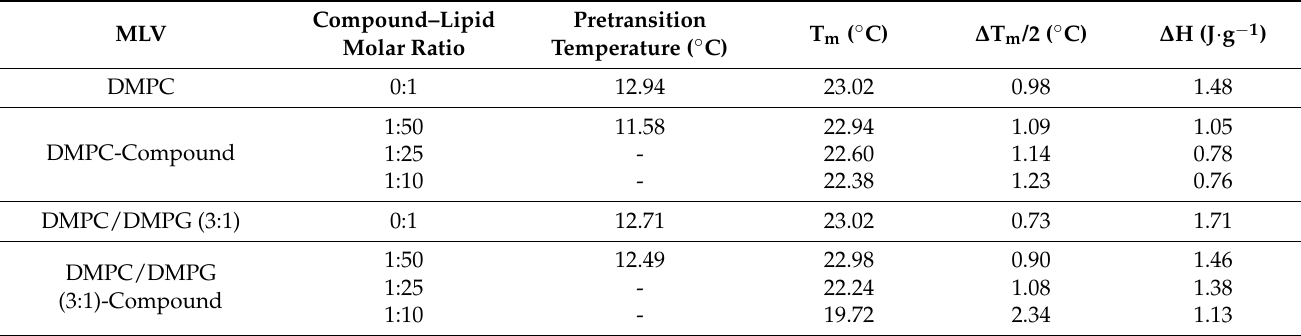
Table 1. T m , ∆ T m /2, and enthalpy transition ( ∆ H) values of MLVs constituted by DMPC and DMPC/DMPG (3:1) before and after the addition of Bz-Im at different Bz-Im –lipid molar